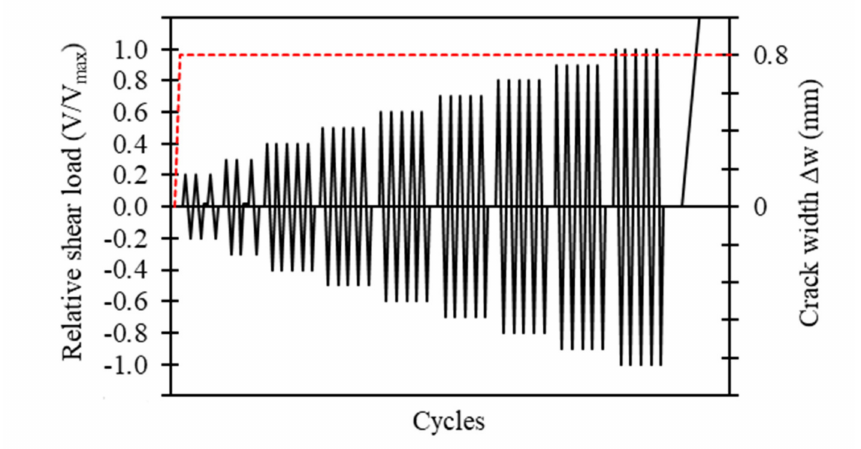
Figure 3. Schematic test procedure for alternating shear load tests in test series C2.4. Redrawn on the basis of EOTA TR 049